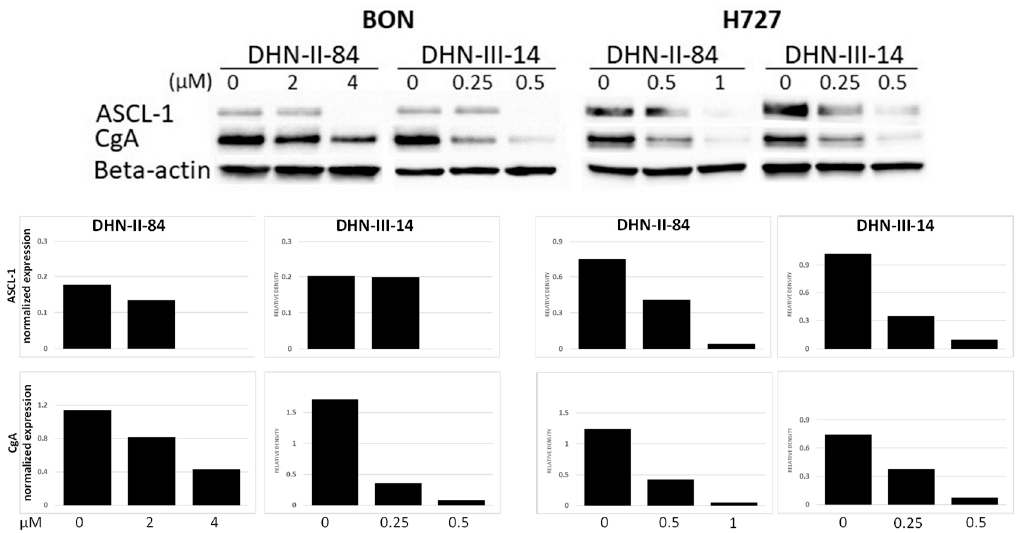
Figure 7. DHN-II-84 and DHN-III-14 decrease neuroendocrine tumor markers in cancer cell lines. A dose-dependent decrease in neuroendocrine tumor markers was observed in BON and H727 cell lines. ASCL-1, achaete-scute homolog 1; CgA, chromogranin A. Protein bands normalized to beta-actin. Relative protein band intensities shown after treatment.